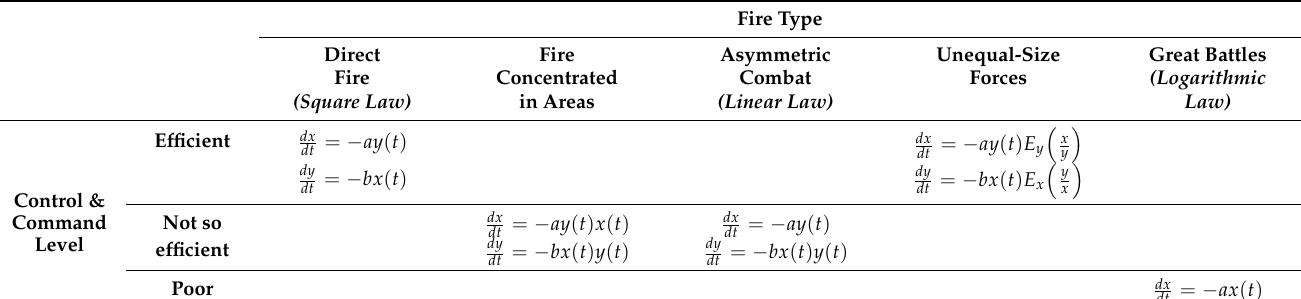
Table 1. Summary of Lanchester equation for combat.